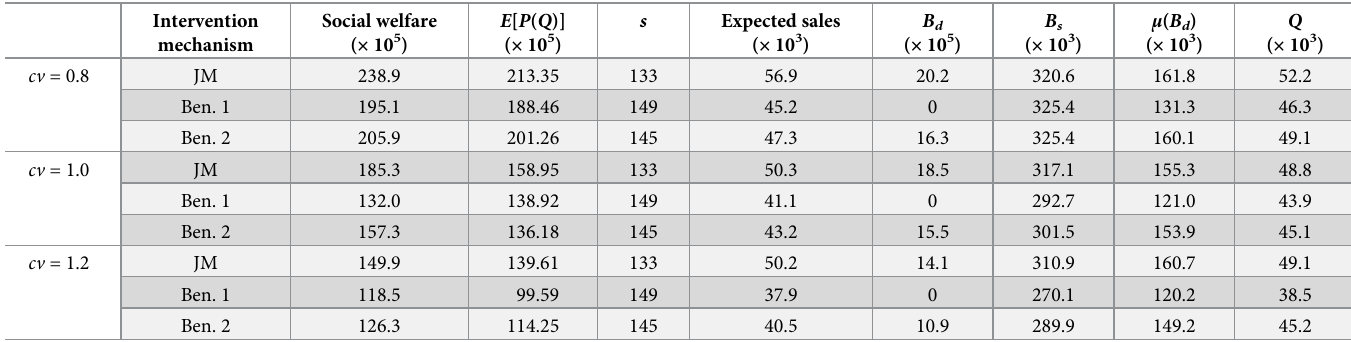
Table 6. The solutions of the long period given in lognormal distribution. Intervention mechanism